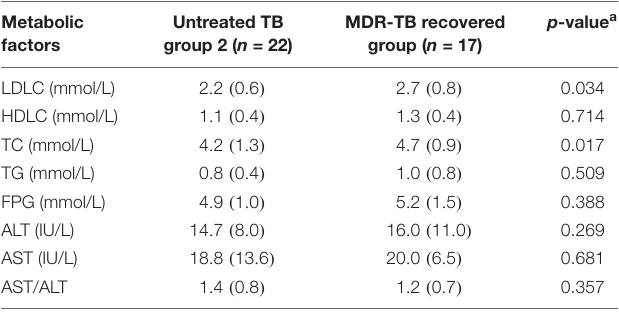
TABLE 2 | Metabolic changes in the MDR-TB recovered group compared to its sex and age matched control group. Metabolic factors